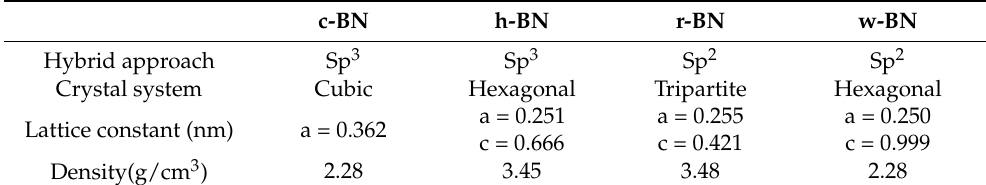
Table 1. Main isomer parameters of BN.